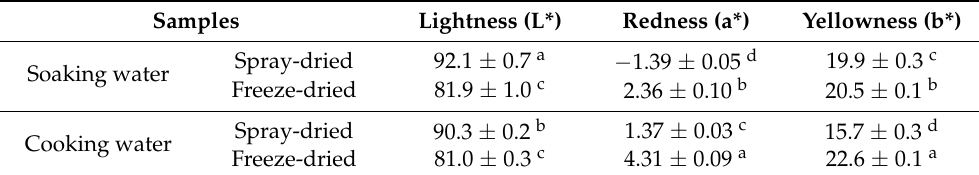
Table 4. The colour parameters (L*—lightness, a*—redness, and b*—yellowness) of spray- dried/freeze-dried split yellow pea soaking/cooking powder. Different letters represent statistical difference ( p <